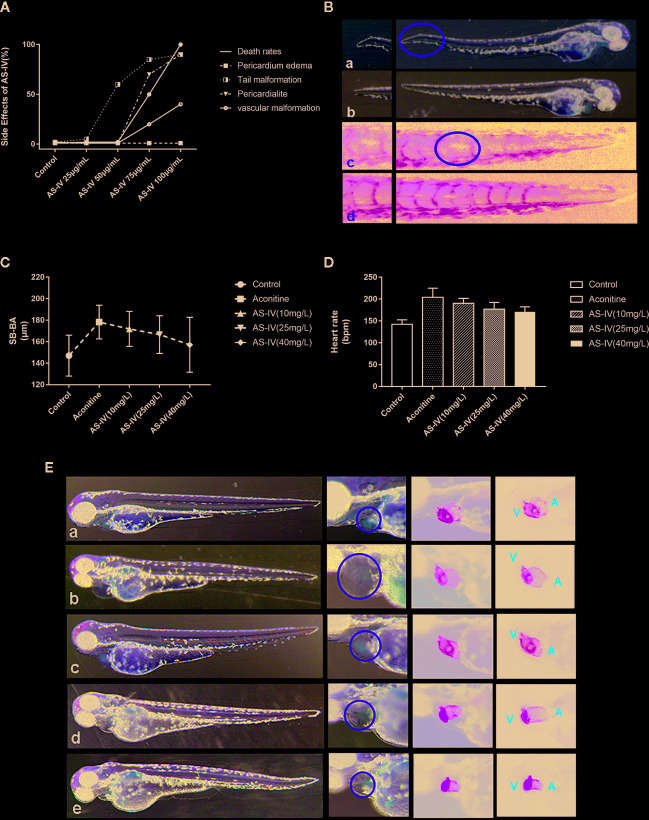

(A) Effects of different doses of AS-IV on mortality, and development of the heart and other parts of the zebrafish. (B) At 50 mg/L AS-IV, abnormal tail vascular development and tail malformation starts to become apparent. (C) Comparison of heart rates of zebrafish in each group (histogram). (D) Comparison of distance SV-BA in each group (trend graph). (E) Changes in heart morphology of zebrafish in each group. (a) Control group, (b) Aconitine group, (c) AS-IV 10 mg/L group, (d) AS-IV 25 mg/L group, (e) AS-IV 40 mg/L group.